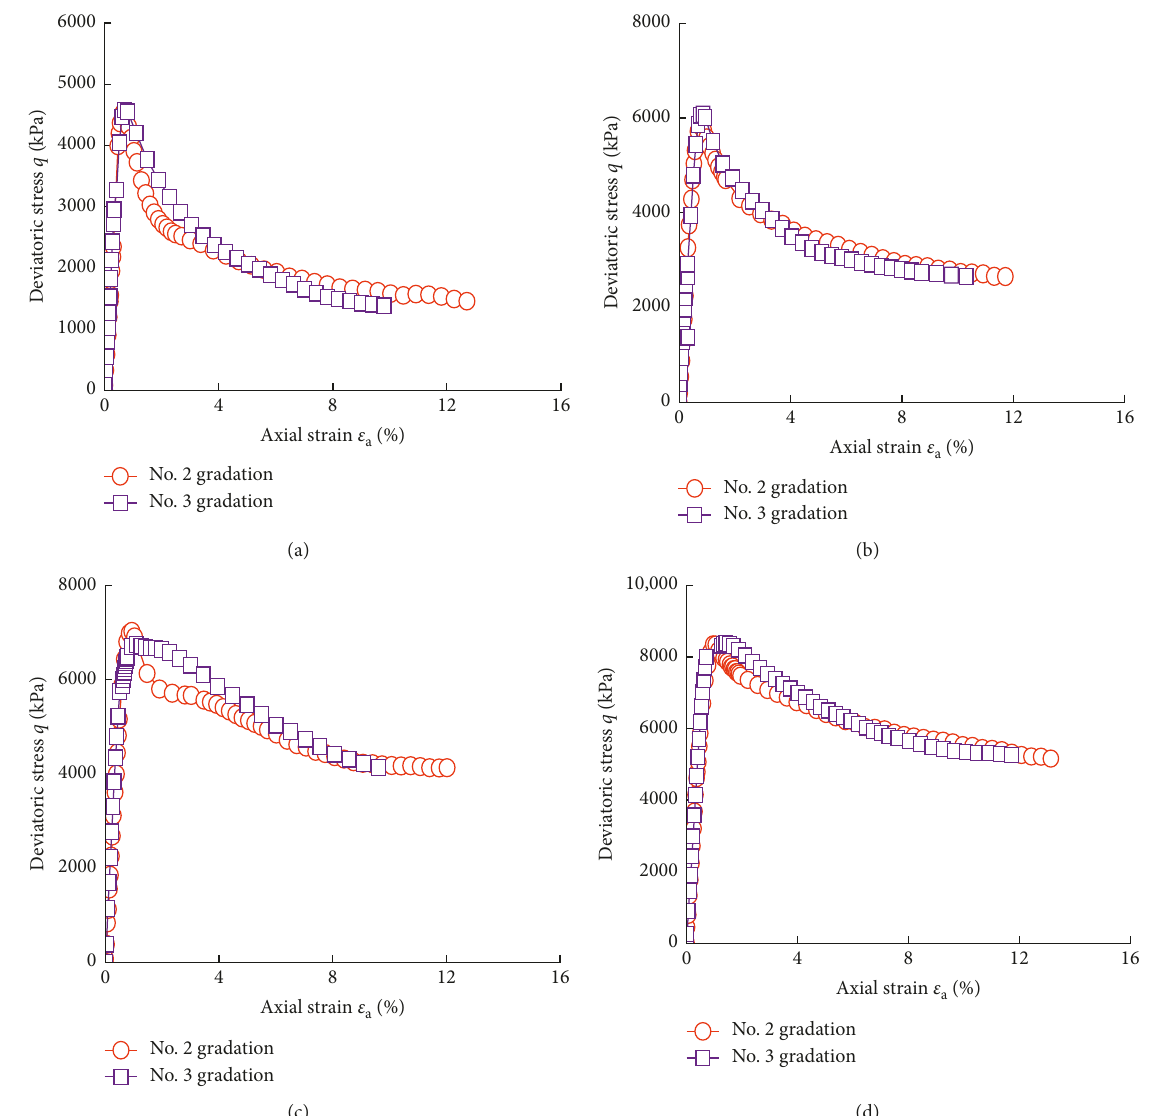
Figure 8: Stress-strain curve of CSG material with regard to the effect of aggregate gradation under various confining pressures: (a) 300kPa; (b) 600kPa; (c) 900kPa; (d)